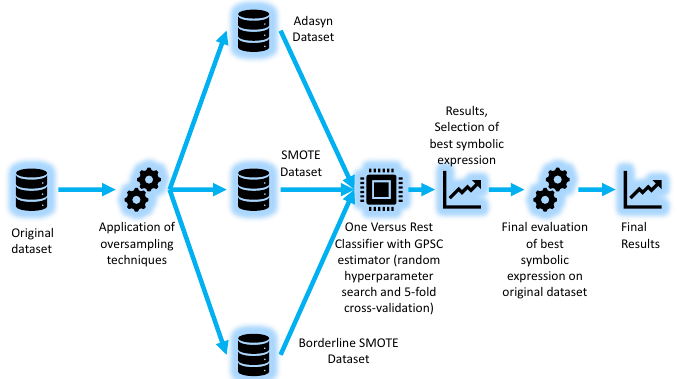
Figure 1. The flowchart of the research methodology used in this